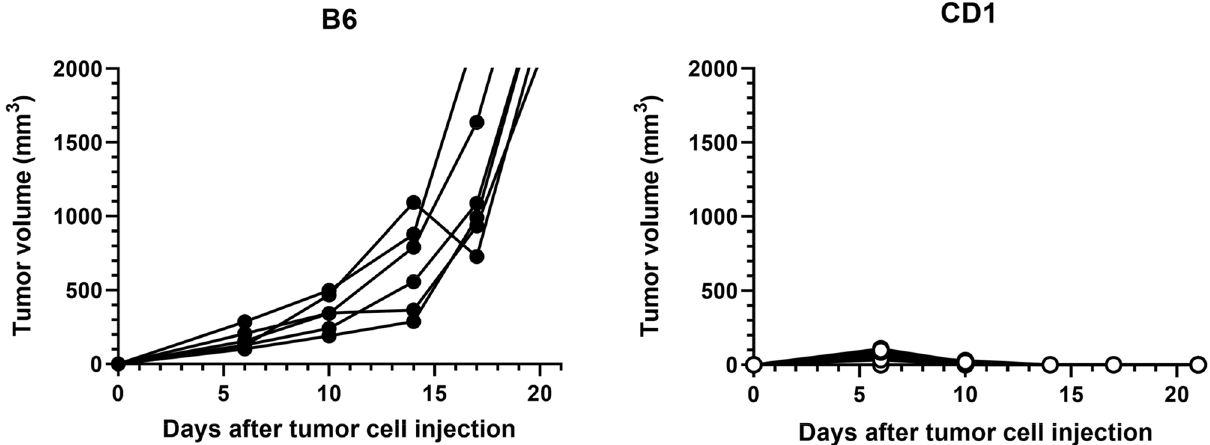
Figure 5. Tumor cell inoculation into C57BL/6NCrl (B6) and CD1 mice. B6-derived cancer cells (MC38 cells) were transplanted into the right flank at 1 × 10 6 cells/head subcutaneously (day 0), and tumor volumes were measured on days 6, 10, 14, 17, and 21. Tumor growth curves of six B6 (filled circles) and 10 CD1 (open circles) mice. Tumor cells were engrafted and grew rapidly, exceeding 2000 mm 3 in all B6 mice, whereas all CD1 mice rejected the